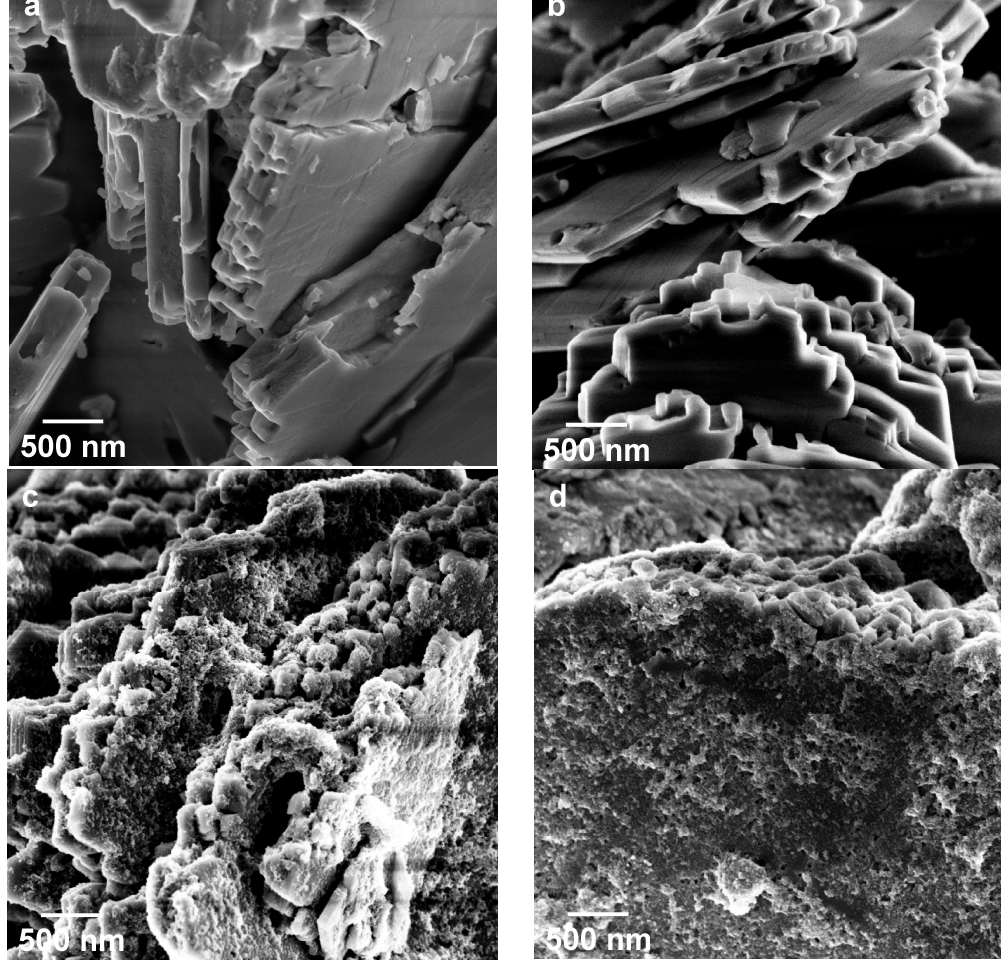
Figure 4. The microstructure of the TiP4 ( a ) 4, TiP2 ( b ), TiP1 ( c ), and TiP0.75 ( d ) samples prepared by hydrothermal treatment of titanium lactate complex at 180 °C in the presence of urea and phosphate ions and with Ti:P ratios of 1:4, 1:2, 1:1, and 1:0.75.